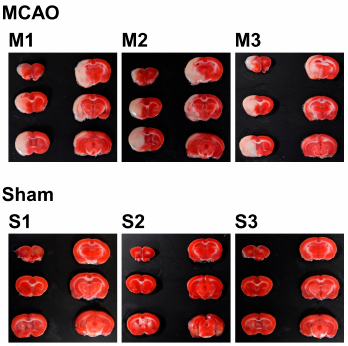
Figure 1. 2,3,5-triphenyltetrazolium chloride (TTC)-stained brain slices of MCAO- or sham-treated rats. The slices were taken from the ventral side and lined up from upper left to bottom right, with the dorsal surface up. The infarcted area is shown as the white part.